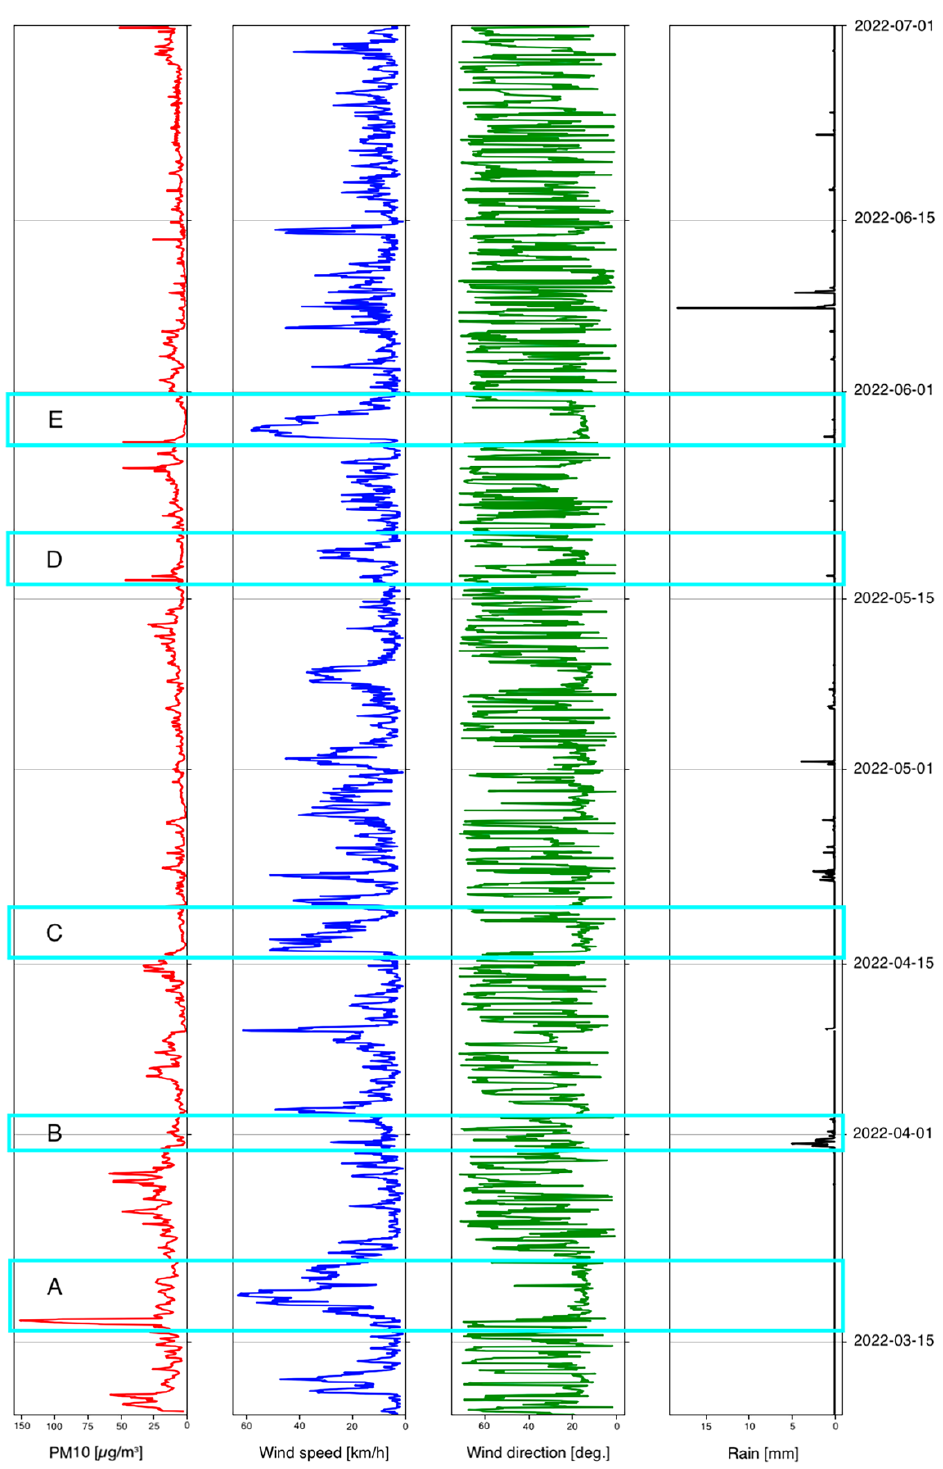
Figure 6. Relationship between particulate matter distribution and weather condition. PM concentra- tions (red) decrease (events A, C, D, E) when the wind speed (blue) increases blowing from nort-east (Bora—green in the range between 60 ◦ and 100 ◦ ). Although rainfalls (black) have been low in the considered period, effects can be seen in the event